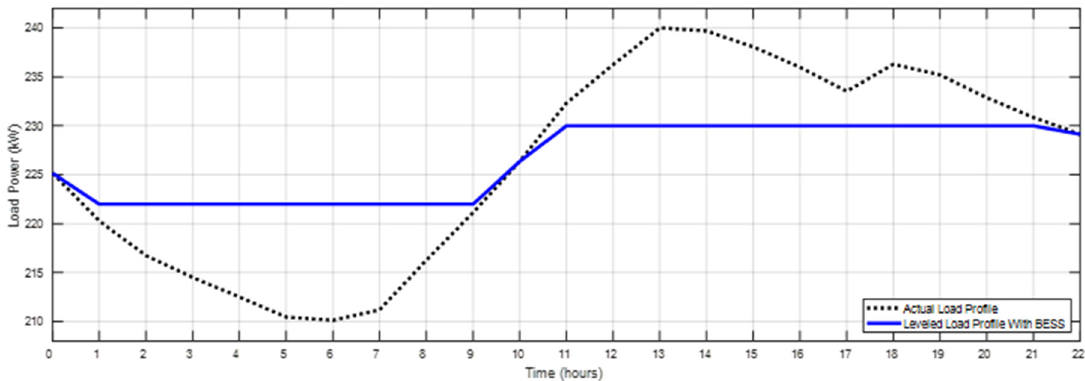
Figure 14. Distributed Case: Maximum Individual Bus-load profile with / without a BESS.